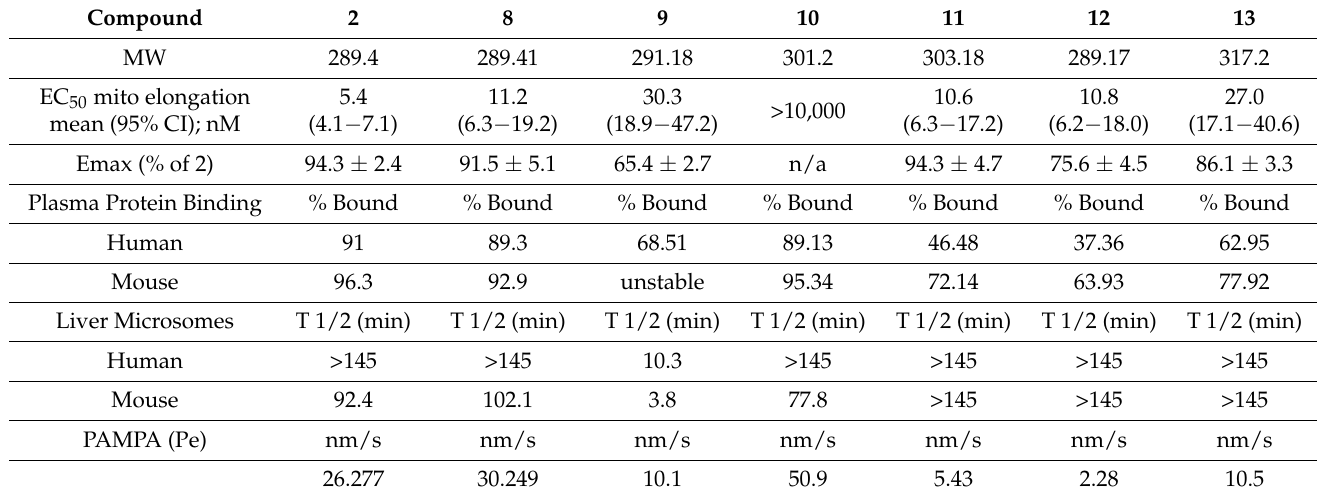
Table 4. Functional and pharmacokinetic properties of 8 linker variants. 2 and 8 values are duplicated from Tables 2 and 3, respectively, for